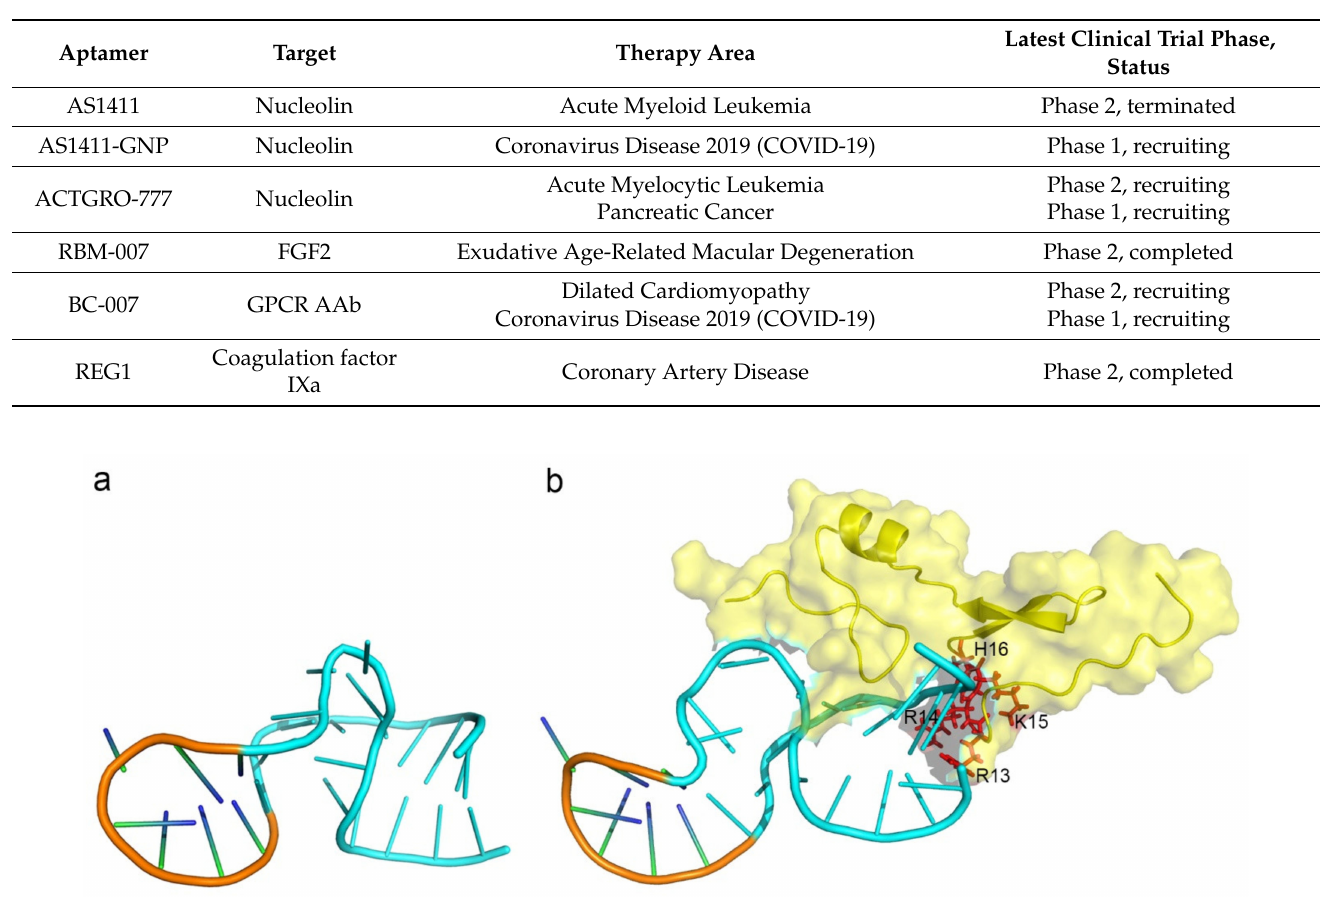
Figure 4. The model structure of Macugen (pegaptanib) and the induced fit-binding interaction with its target protein. ( a ) The structure model of the aptamer, pegaptanib, was shown according to the secondary structure calculated by NMR [131]. The conformation was the free form of the aptamer. ( b ) The interface of the aptamer in complex with the target protein, VEGF165 (PDB ID: 2VGH). The structure and the surface of VEGF165 was shown in yellow. The residues on pegaptanib that undergo a conformational change are shown in blue, while the other residues were shown in orange. The residues on VEGF165 that participated in the interaction of the complex were shown in red and labelled in black (R13, R14, K15,